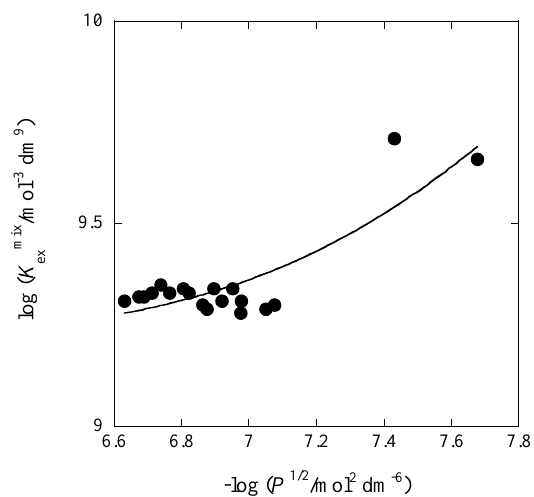
Figure 3. Plot of log K exmix versus − log P 1/2 with B18C6 at [Cd] t /[Pb] t = 88.5. The line is based on Equation (4).